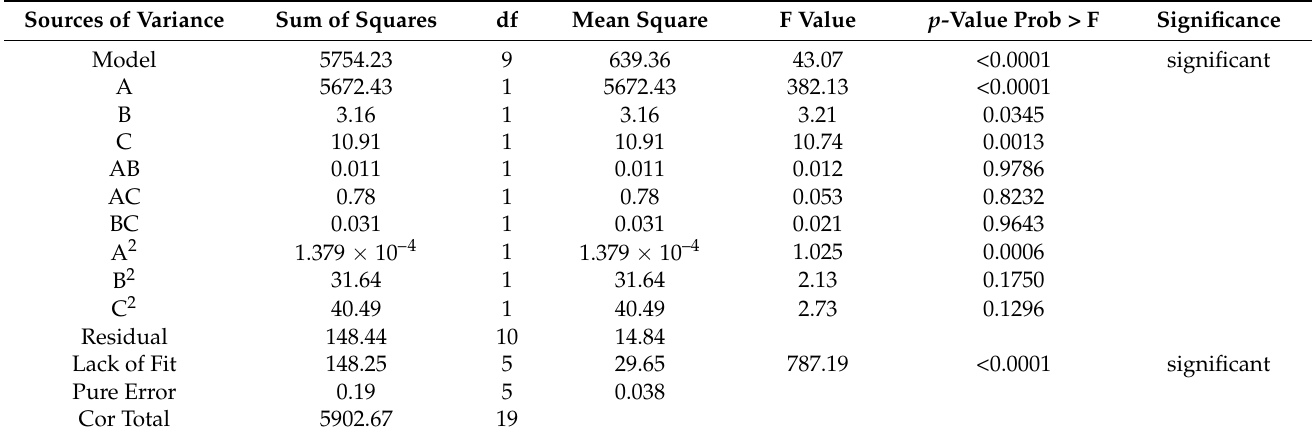
Table 4. Analysis of variance for response surface quadratic model.